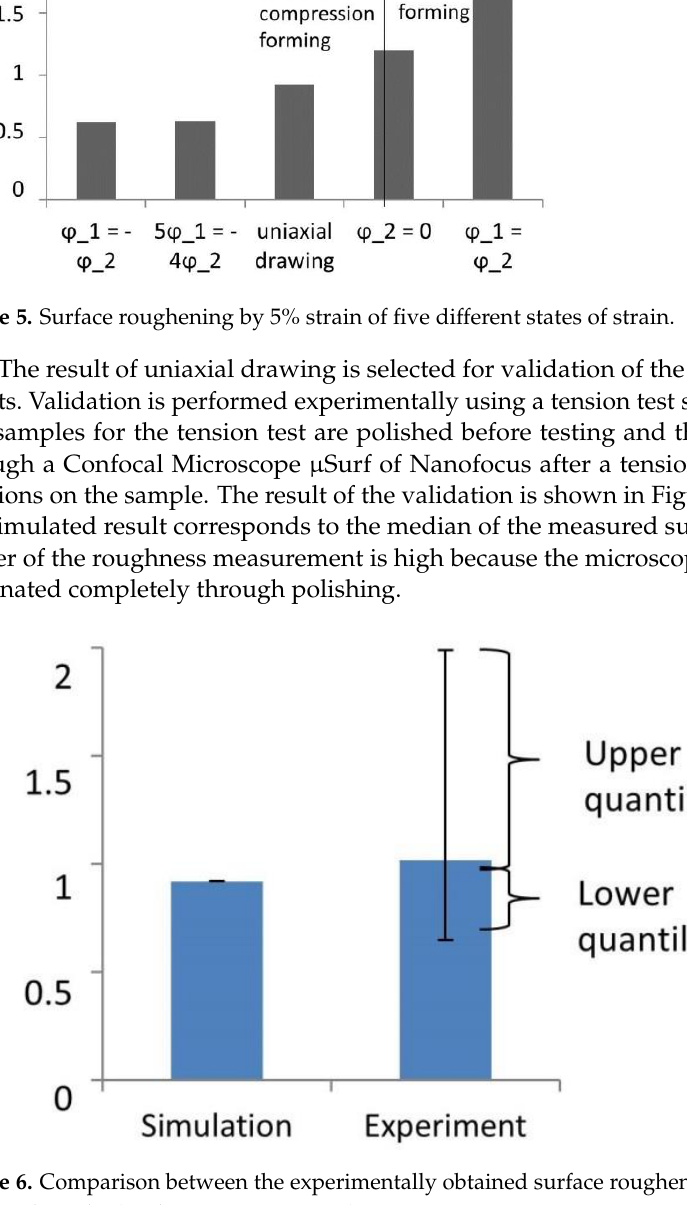
Figure 6. Comparison between the experimentally obtained surface roughening and the numerically predicted results (evaluation at 5% strain).